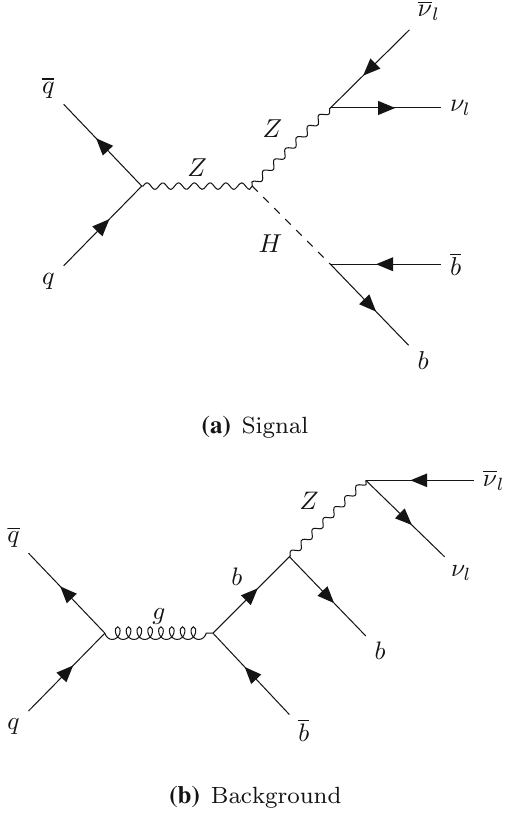
Fig. 1 Representative Feynman